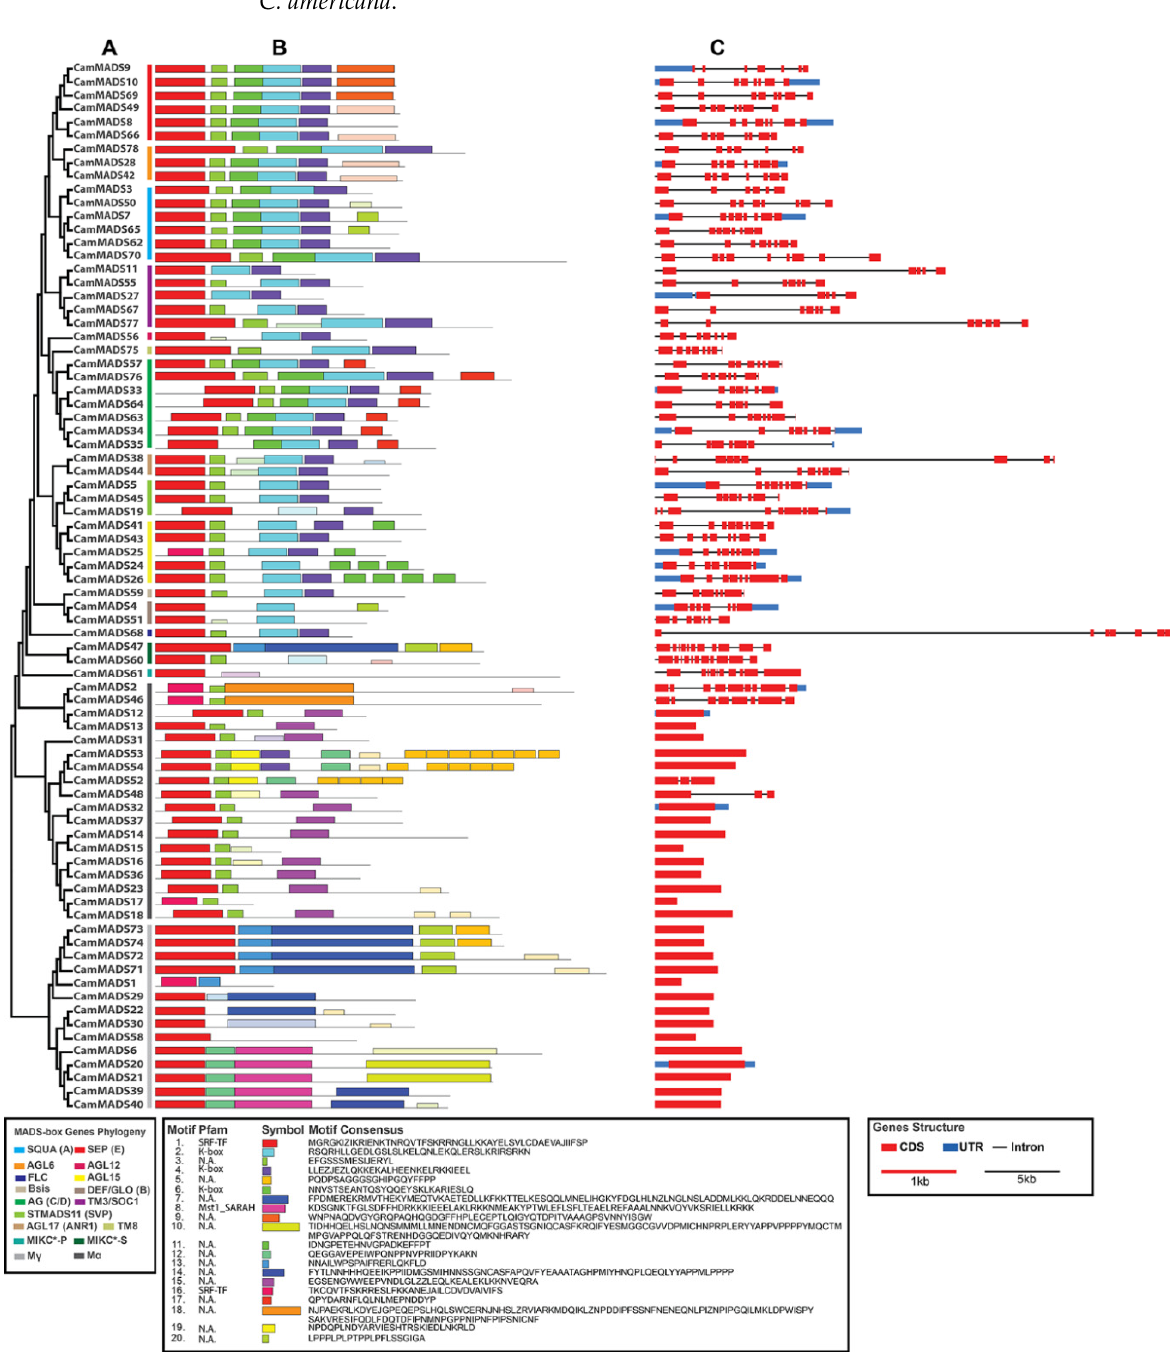
Figure 5. Gene structure and conserved motif analysis of C. americana MADS-box proteins: ( A ) CamMADS proteins phylogenetic relationship, ( B ) motif analysis of CamMADS proteins, each motif is represented by a number in a colored box mid-bottom. Box length corresponds to motif length, ( C ) CamMADS gene structure analysis (exons are in red, introns represented by solid line, and untranslated regions are in blue).